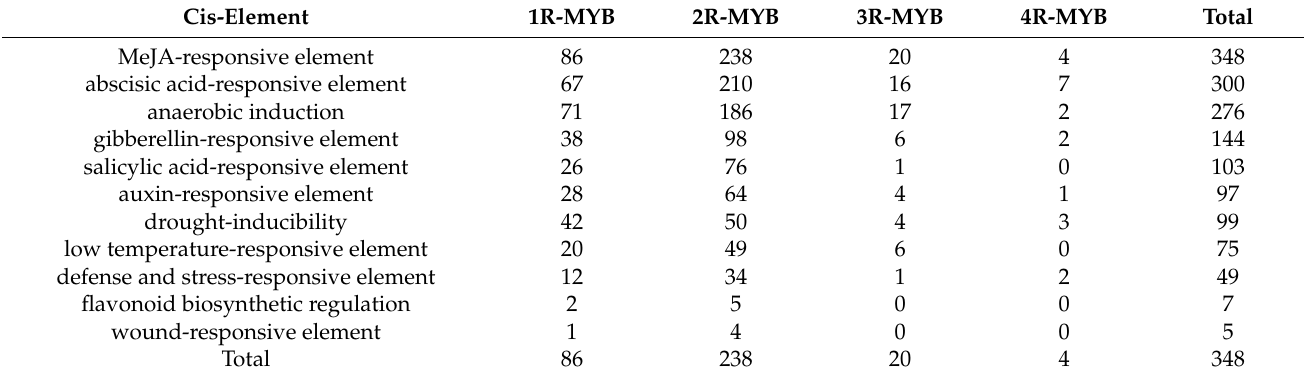
Table 1. The summary of cis-element involved in hormone, stress and development responses in PaMYB promoters.